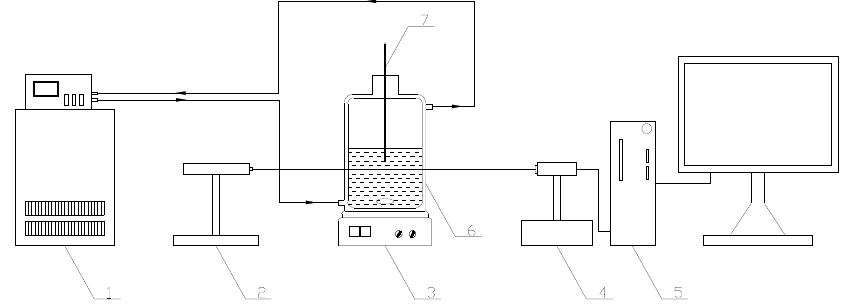
Figure 1. For metastable zone width experiments. 1. Thermostatic bath. 2. Laser generator. 3. Electromagnetic stirrer. 4. Photoelectric converter. 5. Numerical indicator. 6. Jacketed glass vessel. 7. Precise thermometer.